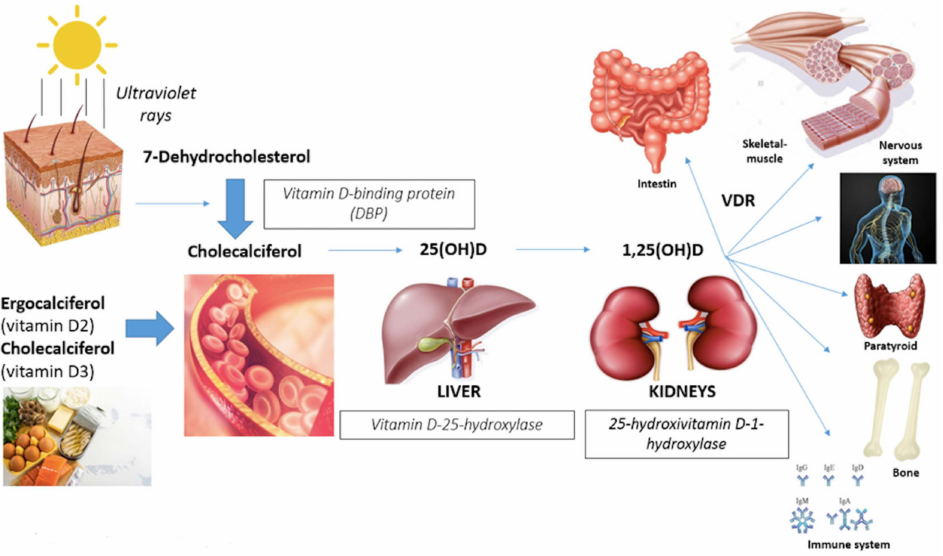
Figure 1. E ff ects of Vitamin D and target